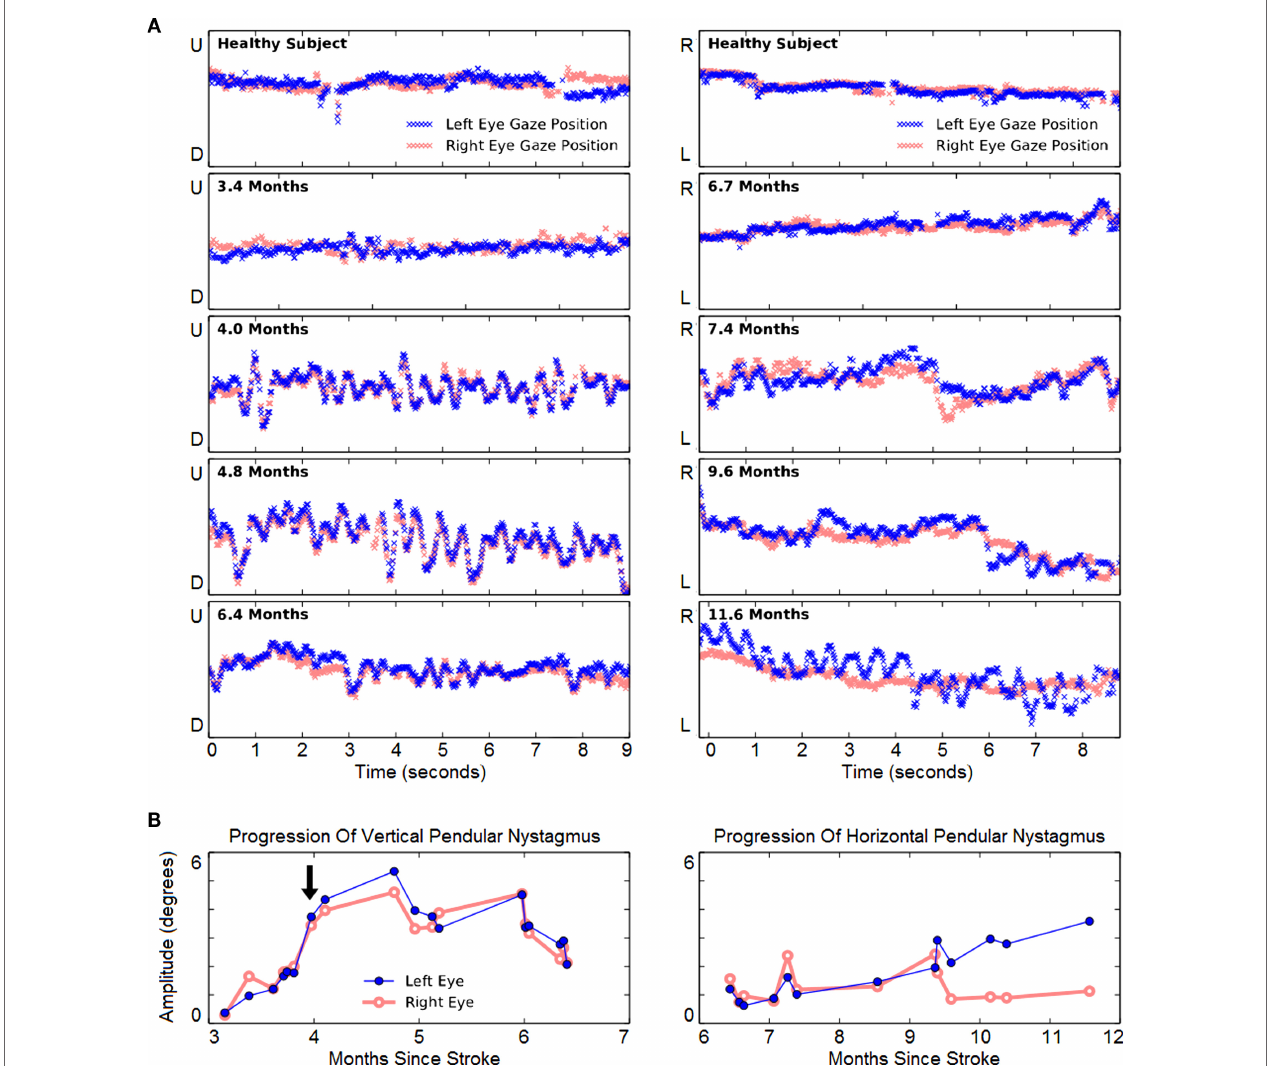
FIGURe 4 | evolution of involuntary eye movements . (a) Left panels: representative 9-s vertical gaze traces during rightward tracking. Recordings from a neurologically healthy subject (top panel) and from the case subject (lower four panels) are presented. The Y -axis span corresponds to 22.8° of vertical visual field. The subject initially showed mild vertical pendular nystagmus (VPN), which increased and endured until 6 mont left-eye nystagmus hs, and then improved. Right panels: representative 9-s horizontal gaze traces during downward tracking. The Y -axis span corresponds to 22.8° of horizontal visual field. The first evidence of horizontal pendular nystagmus (HPN) emerged in both eyes at 7.4 months. Thereafter, right-eye nystagmus was largely unchanged, but left-eye nystagmus progressively increased. (B) Longitudinal change of VPN (left panel) and HPN (right panel). The arrow indicates the subject’s first report of the onset of involuntary eye